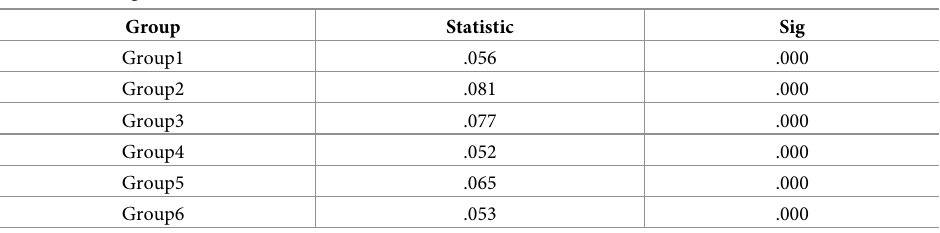
Table 2. Kolmogorov-Smirnov test.